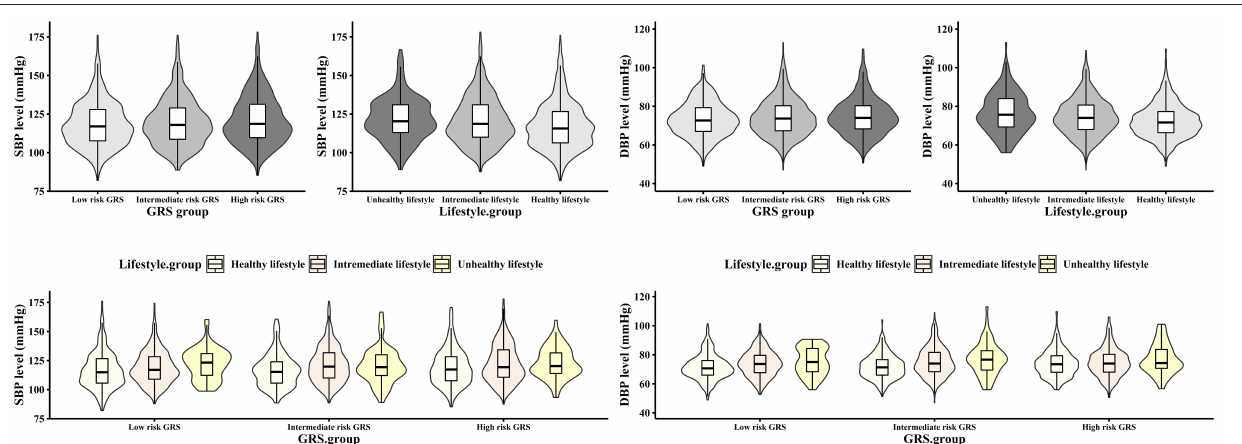
Frontiers in Public Health |